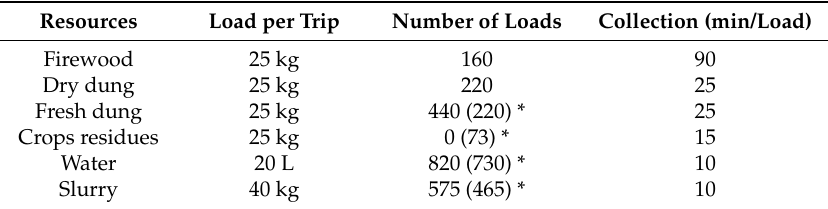
Table 2. Annual number of loads of biomass and water and the time for collection of each load.